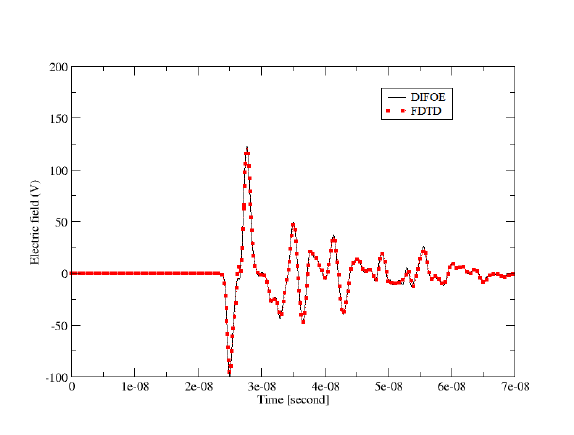
Figure 6: Example of a segment going from Node(j,1) to Node(j,2) crossing two cells and divided in two